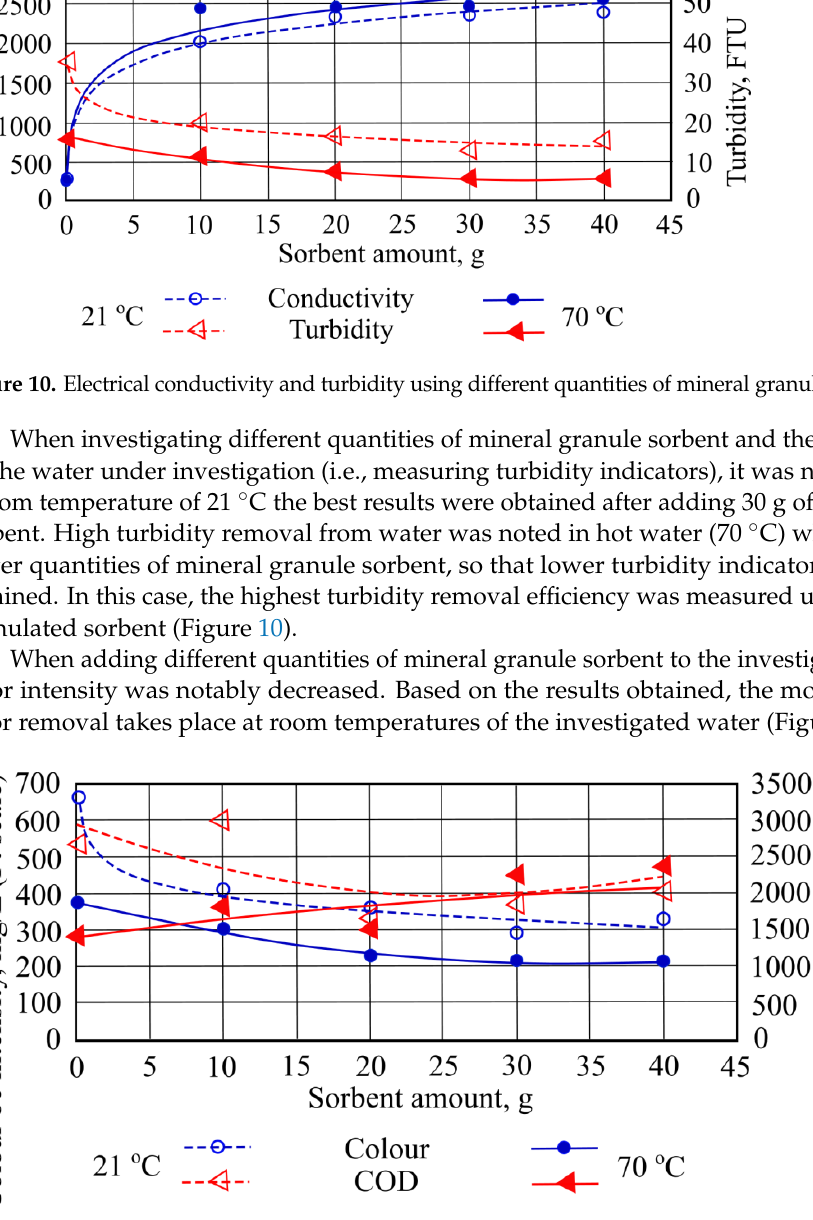
Figure 11. Color and chemical oxygen demand, when different quantities of mineral granulated sorbent are added to the water.